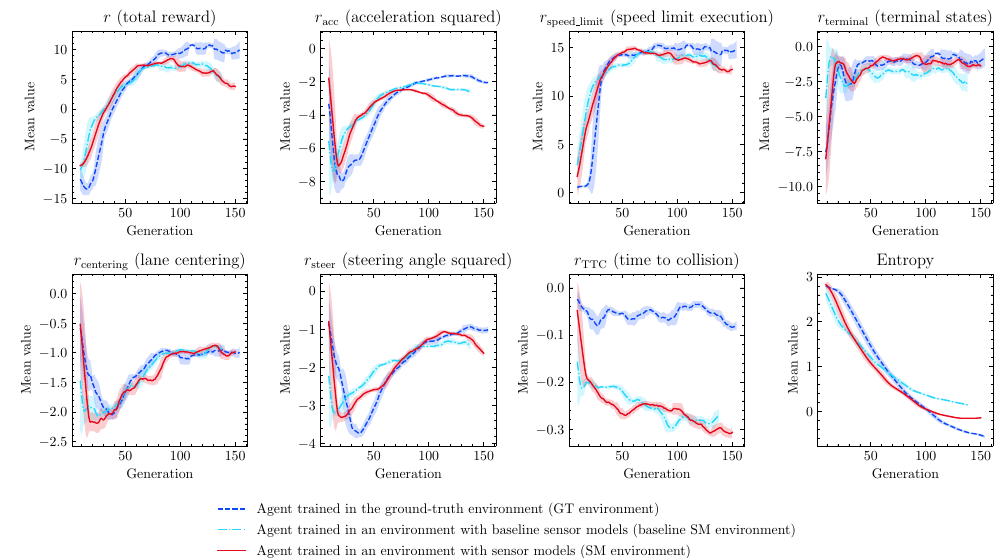
Figure 3. Training progress. Training was performed separately in environments with the described sensor models based on Ornstein–Uhlenbeck processes (OU-SM), baseline sensor models that utilize Gaussian noise (G-SM), and with the ground-truth sensor data (GT). Training in all environments progressed similarly, with the agent trained in the OU-SM environment reaching a slightly lower performance.